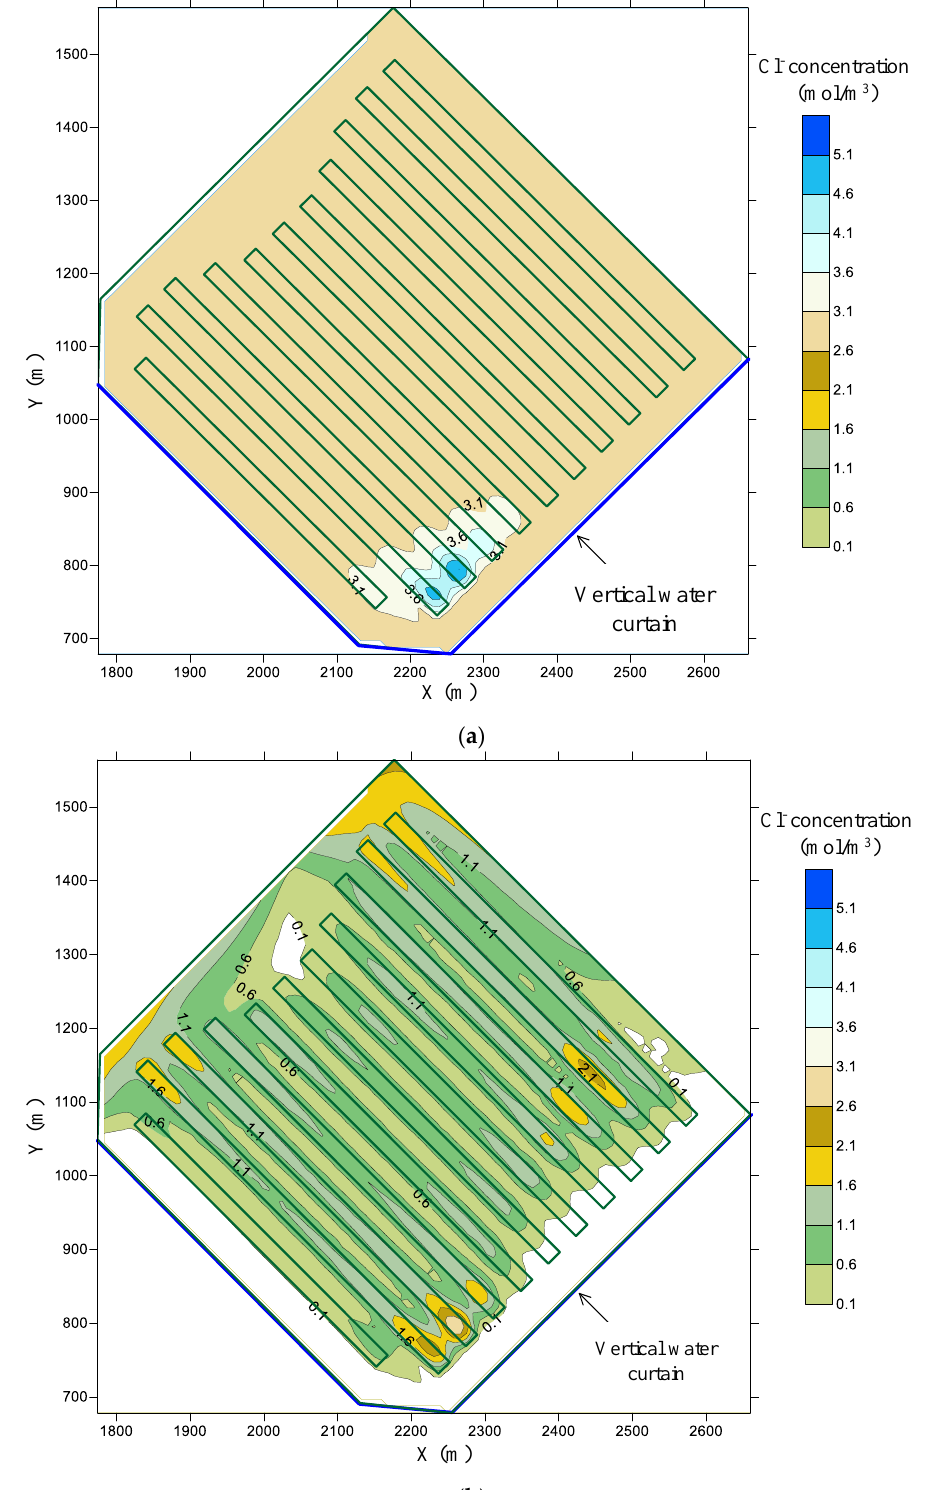
Figure 23. Cl − concentration at the cavern bottom after 50 years when vertical water curtain is only applied at the southeast of the cavern group: ( a ) groundwater injected into the water curtain system: ( b ) freshwater injected into the water curtain system.